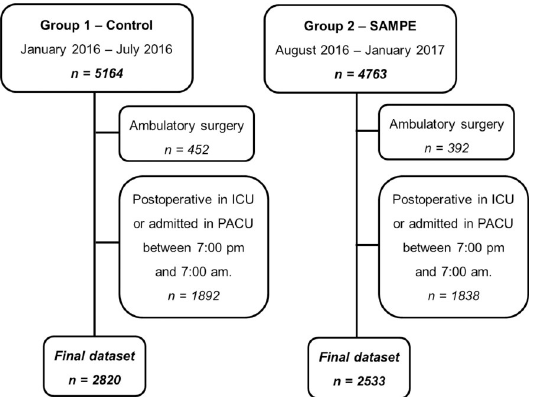
Fig 2. Trial diagram depicting the analysis of the SAMPE Model implementation. ICU, Intensive Care Unit; PACU, Postoperative Anaesthetic Care Unit.